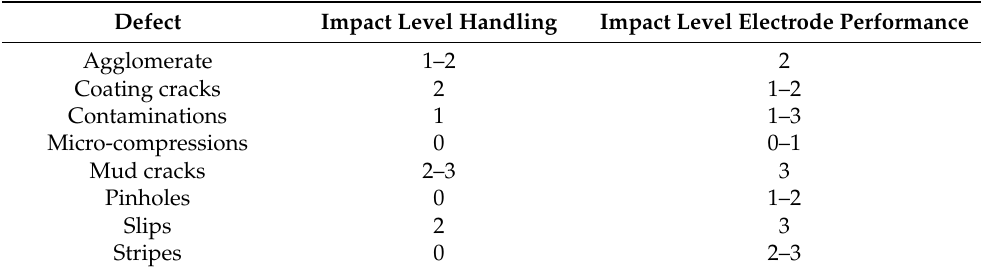
Table 1. Impact level of different defects on handling in consecutive process steps and on the electrochemical electrode performance: 0 = none, 1 = low, 2 = medium, and 3 =